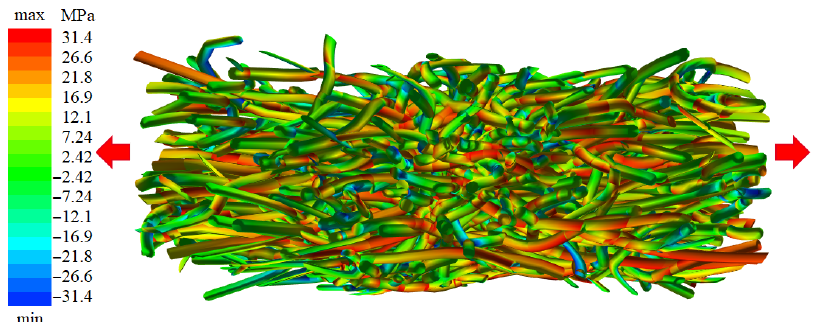
Figure 13. Reorganization of leather structure during horizontal tension test. Simulation was performed on a 5 mm cubic specimen with volume fraction of 63% (L3: zebu back). Colors indicate axial stress values from minimal (blue) to maximal